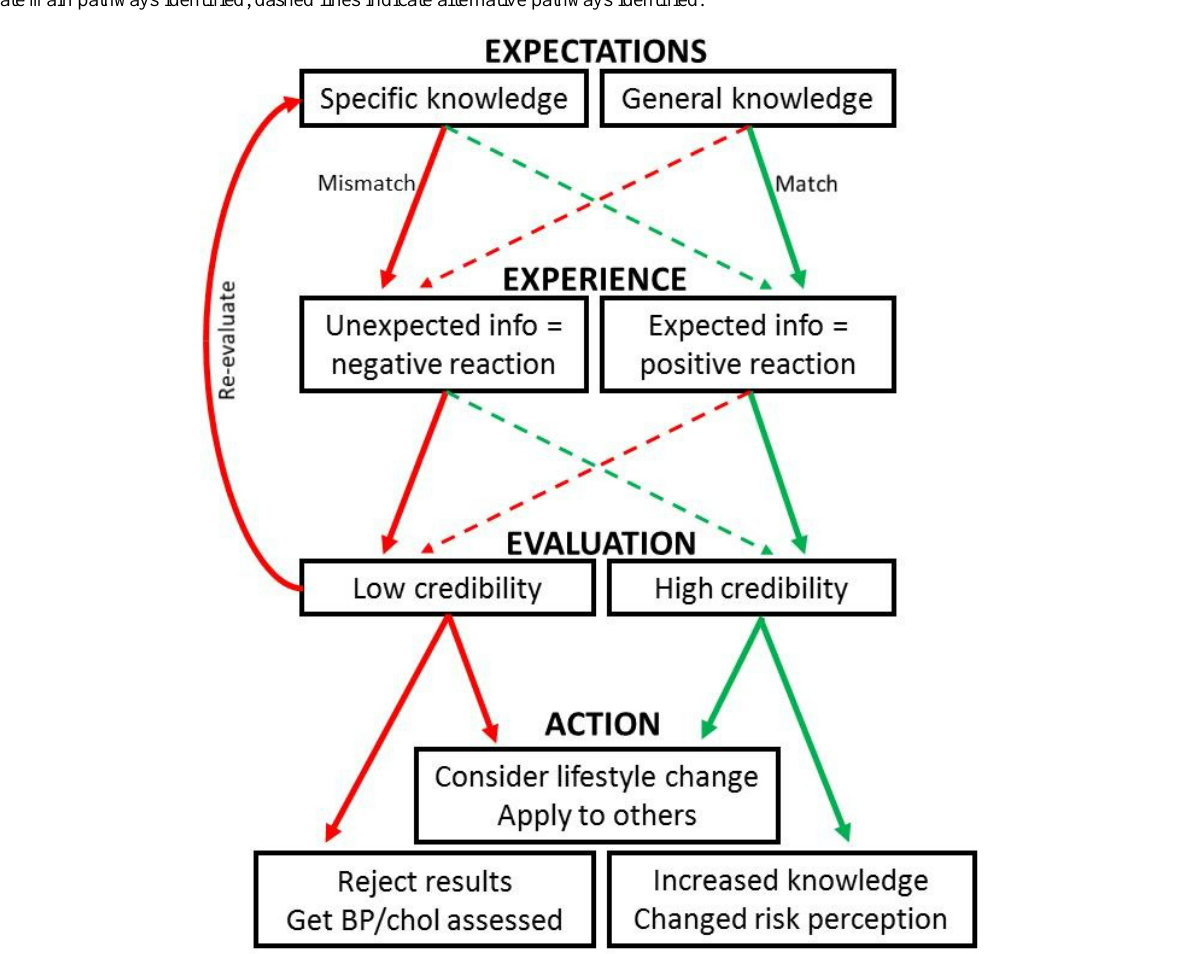
Figure 1. Process of using risk calculators: red arrows indicate low credibility pathways, green arrows indicate high credibility pathways, solid lines indicate main pathways identified, dashed lines indicate alternative pathways